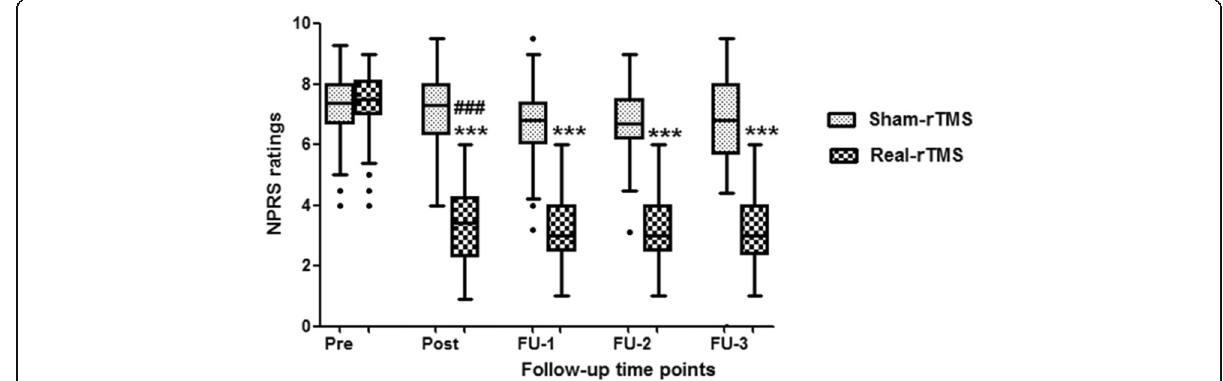
Fig. 1 : Effect of rTMS on subjective pain rating scores in FMS. Subjective pain assessed by numerical pain rating scale (NPRS) in Sham ( n = 41) and Real-rTMS ( n = 45) group at each time points;pre, post and follow up (FU-1 = 15 days, FU-2 = 3 months and FU-3 = 6 months post-rTMS). Hash (#) symbol indicates within group p value. Asterisk (*) symbol indicates p value between Sham-rTMS and Real-rTMSgroup. * p or # p < 0.05; ** p or ## p < 0.01; *** p or ### p <